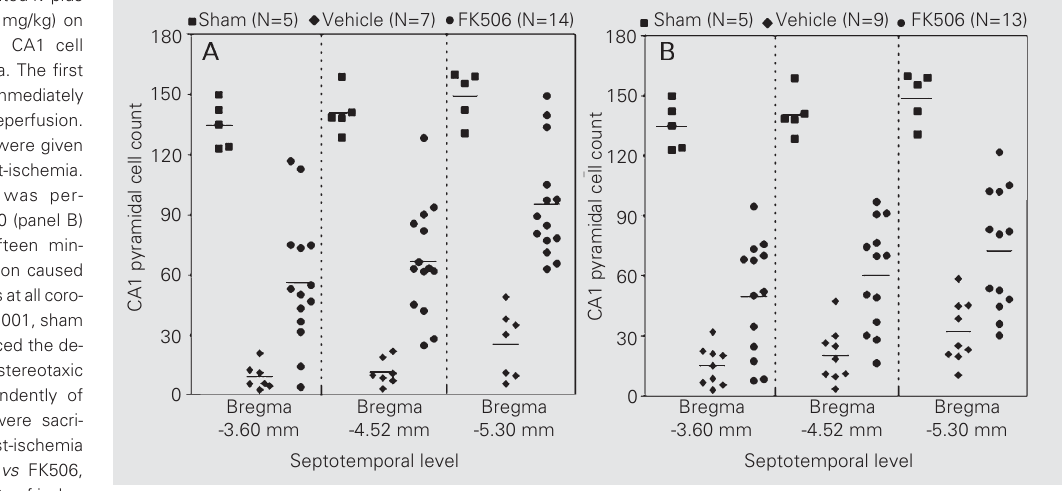
Figure 2. Effect of repeated iv plus ip doses of FK506 (1.0 mg/kg) on hippocampal pyramidal CA1